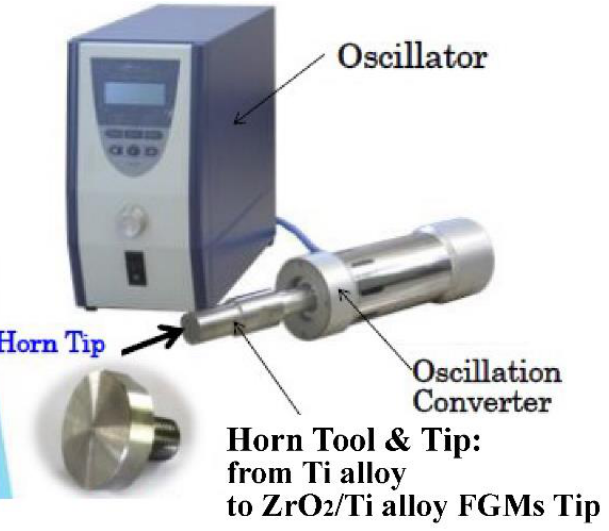
Figure 40. Ultra-sonic homogenizer (manufactured by Mitsui Electric Co., Ltd./Noda city, Chiba pref., Japan).